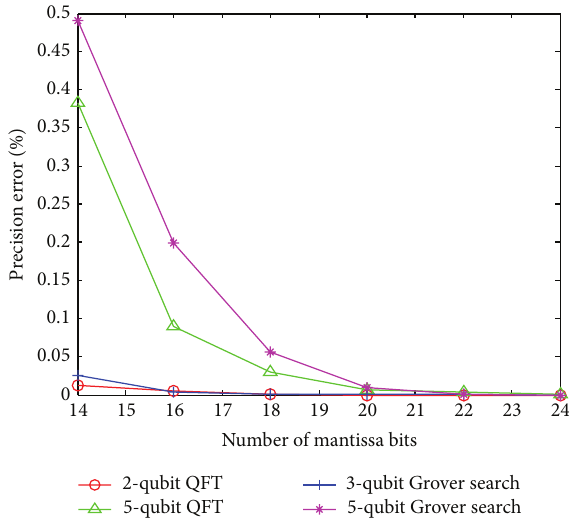
Figure 16: Precision error against different fixed point formats